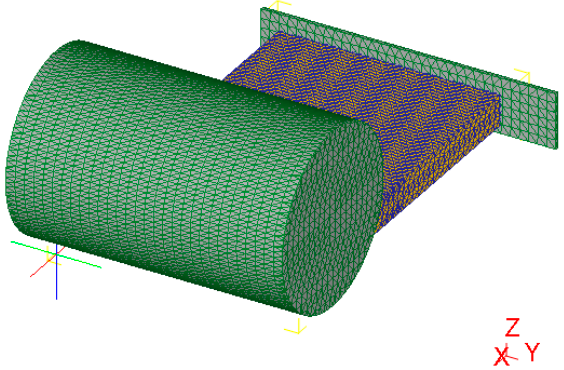
Figure 4. Finite element (FE) model and meshing for HHR 2 process.